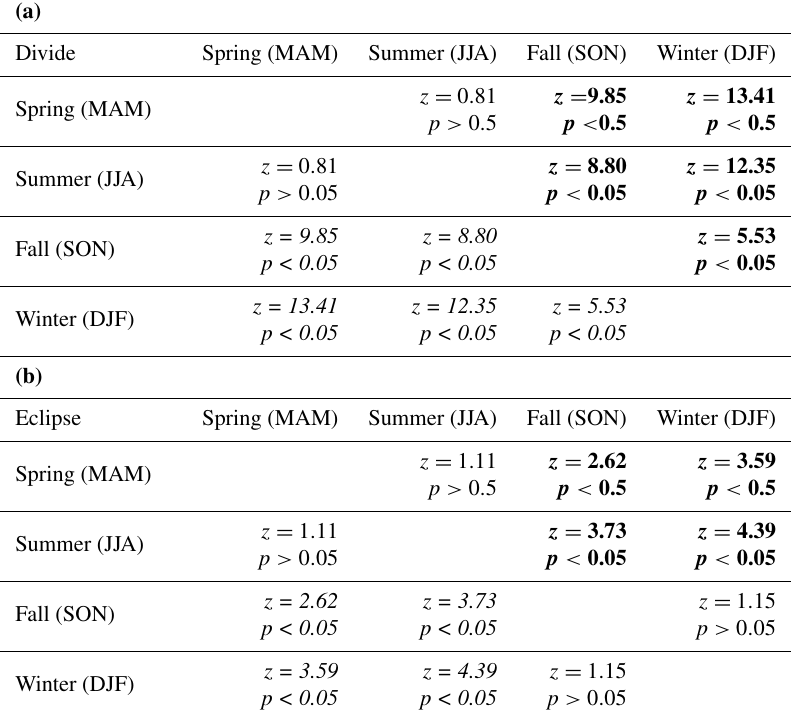
Table 3. Results for Wilcoxon rank sum tests between seasonal MODIS LST offsets at (a) Divide and (b) Eclipse. Bolded cells indicate a more pronounced cold offset in the column season; italicized cells indicate a more pronounced cold offset in the row season; and standard-font cells indicate no significant difference between the